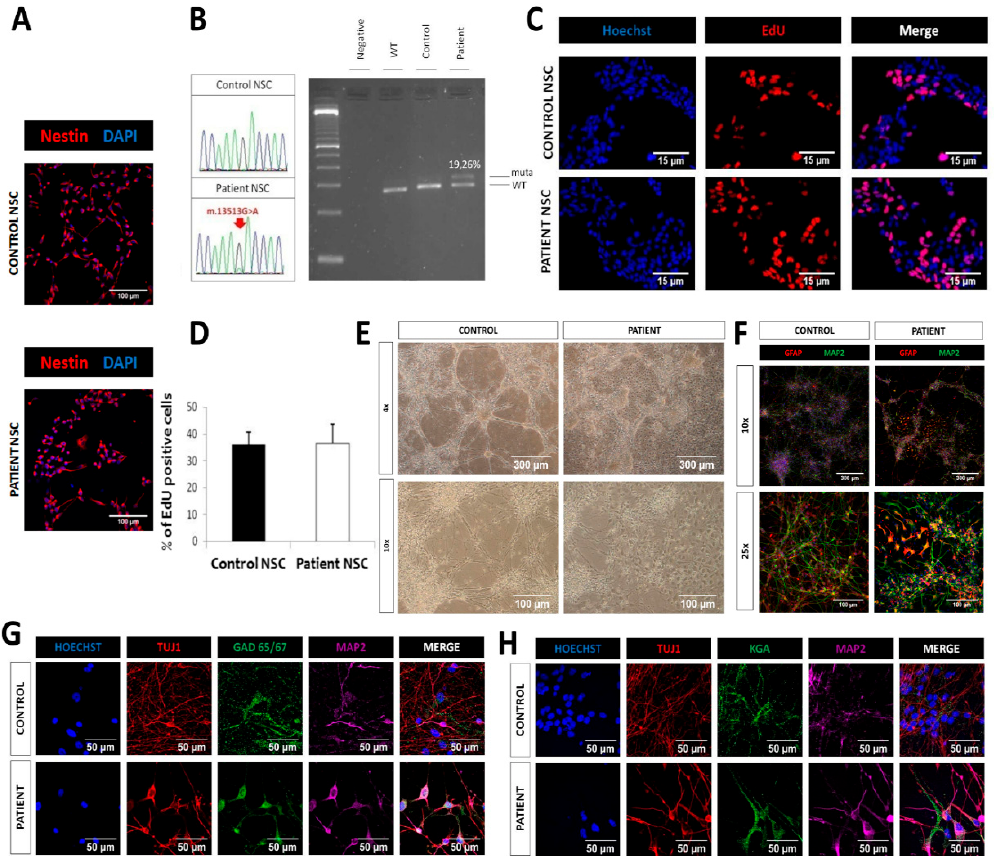
Figure 3. LS neural stem cells (NSCs) manifested similar proliferative and di ff erentiation capacity. ( A ) Immunofluorescence analysis of the neural stem cell marker nestin, manifesting an e ffi cient generation of NSCs from iPSCs; scale bar: 100 µ m. ( B ) Electropherograms showing the mutation m.13513G > A in patient NSCs and its absence in control NSCs (left) and heteroplasmy levels of m.13513G > A mutation by RFLP followed by Agilent quantification. ( C ) Proliferation assay of NSCs with the thymidine analogue 5-ethynyl-2’-deoxyuridine (EdU). Scale bar: 15 µ m. ( D ) Quantification of EdU (percentage of EdU +/ Hoechst + ). ( E ) Bright field images (4 × and 10 × ) of neural populations obtained after di ff erentiation of NSCs. ( F ) Immunofluorescence analysis of MAP2, a marker of mature neurons, and GFAP, a marker of astrocytes, in the neural populations obtained after di ff erentiation of NSCs in N2B27 for 3 weeks ( G – H ) Immunofluorescence analysis of the GABAergic marker GAD 65 / 67 and glutamatergic marker KGA together with neuronal markers (Tuj1 and